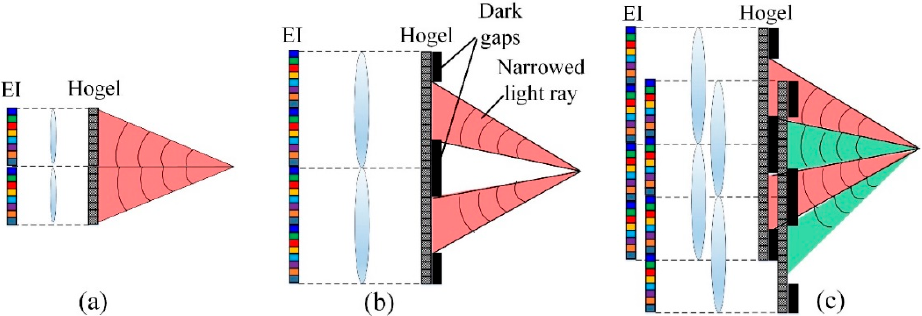
Figure 10. ( a ) A conventional case with a small focal length. ( b ) Increased focal length with aperture filtering, resulting in dark gaps. ( c ) Increased focal length with aperture filtering and MALT.